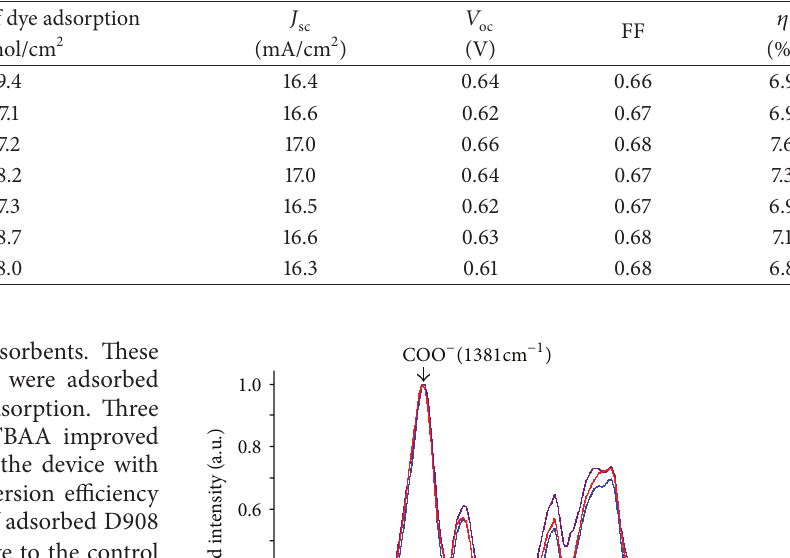
Table 2: Photovoltaic parameters of DSC devices with acetic acid derivatives.